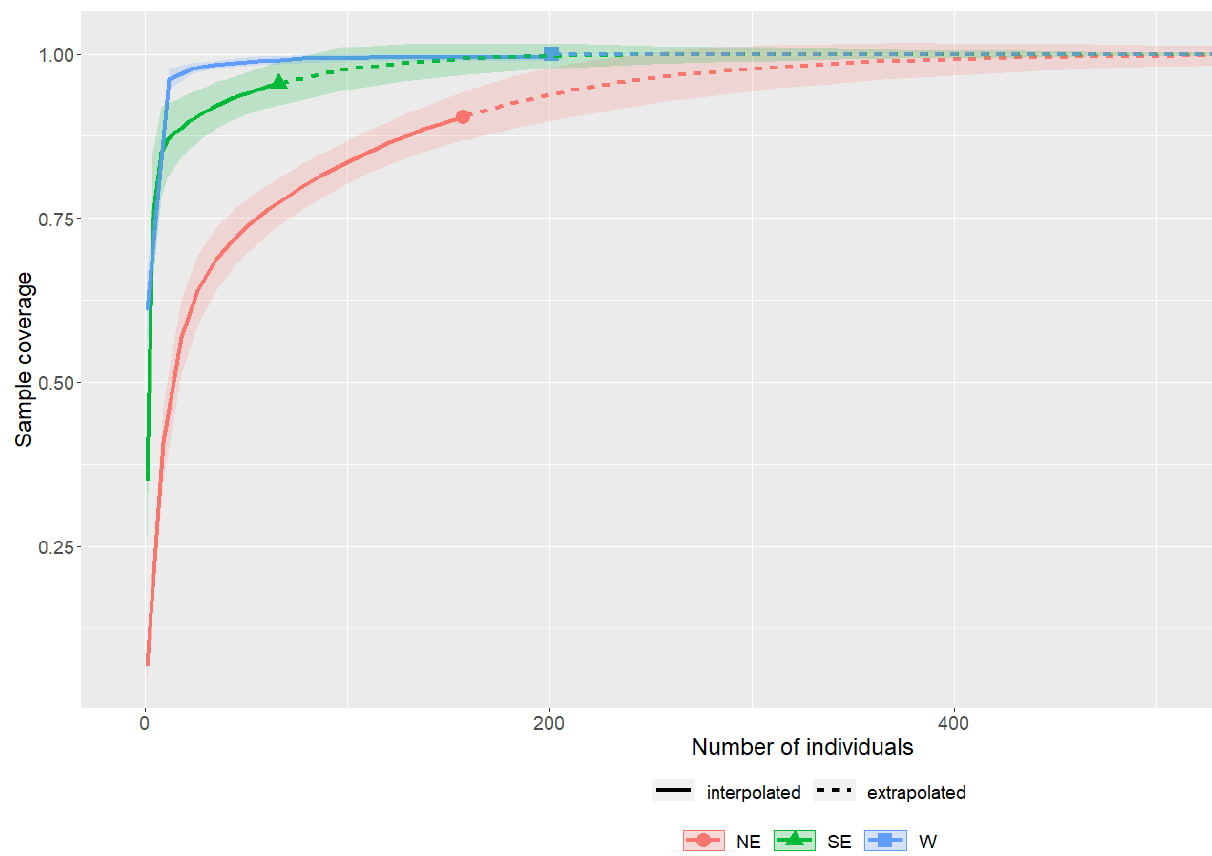
Figure 2. The sample completeness curves for three preserved populations of European mink (1 on the vertical axis means reaching the level of full coverage of the predicted, real level of haplotype richness of the general population; population abbreviations are as described in the main text).